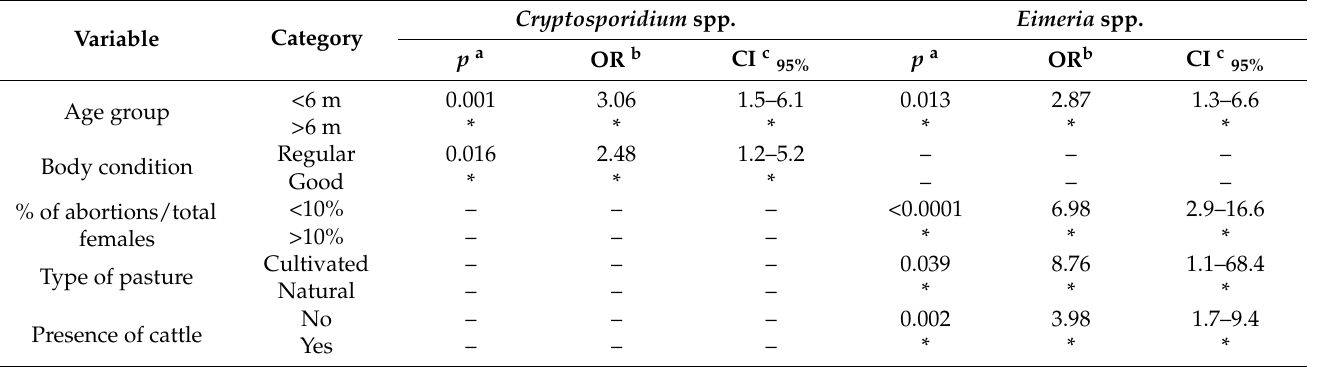
Table 4. Risk factors associated with Cryptosporidium spp. and Eimeria spp. in goats from Ecuador, obtained by multivariable logistic regression